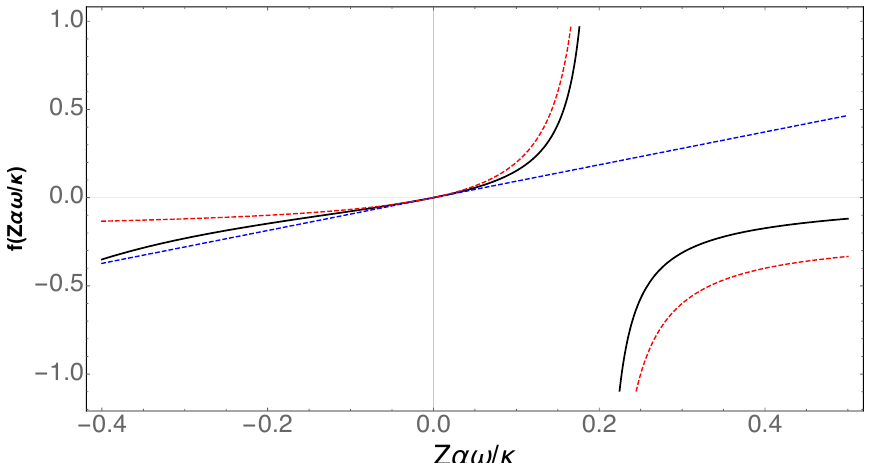
Figure 2 . The black curve plots the right-hand side of eq. (4.2) f ( Z(cid:11)!=(cid:20) ) = (cid:0)(1 + 2 (cid:16) )(cid:0)( (cid:0) (cid:16) (cid:0) Z(cid:11)!=(cid:20) ) = ((cid:0)(1 (cid:0) 2 (cid:16) )(cid:0)( (cid:16) (cid:0) Z(cid:11)!=(cid:20) )) vs Z(cid:11)!=(cid:20) , with the zero of energy chosen to be the eigenvalue of the n = 2 and j = 1 states. Standard Dirac energy levels correspond to places where the plotted 2 quantity vanishes, while (cid:12)nite-size e(cid:11)ects of the source correspond to those energies for which (4.2) instead equals a speci(cid:12)ed nonzero (positive) value. The dashed curves show two approximations to (4.2) that provide useful analytic expressions for energy shifts. The blue (red) curve shows the single-pole (double-pole) approximation to (4.2), described in the main text. In order to better display the shape of these curves, for plotting purposes we use (cid:16) = 0 : 9 (and so Z(cid:11) (cid:24) 0 : 45) and for concreteness expand about the pole at n =